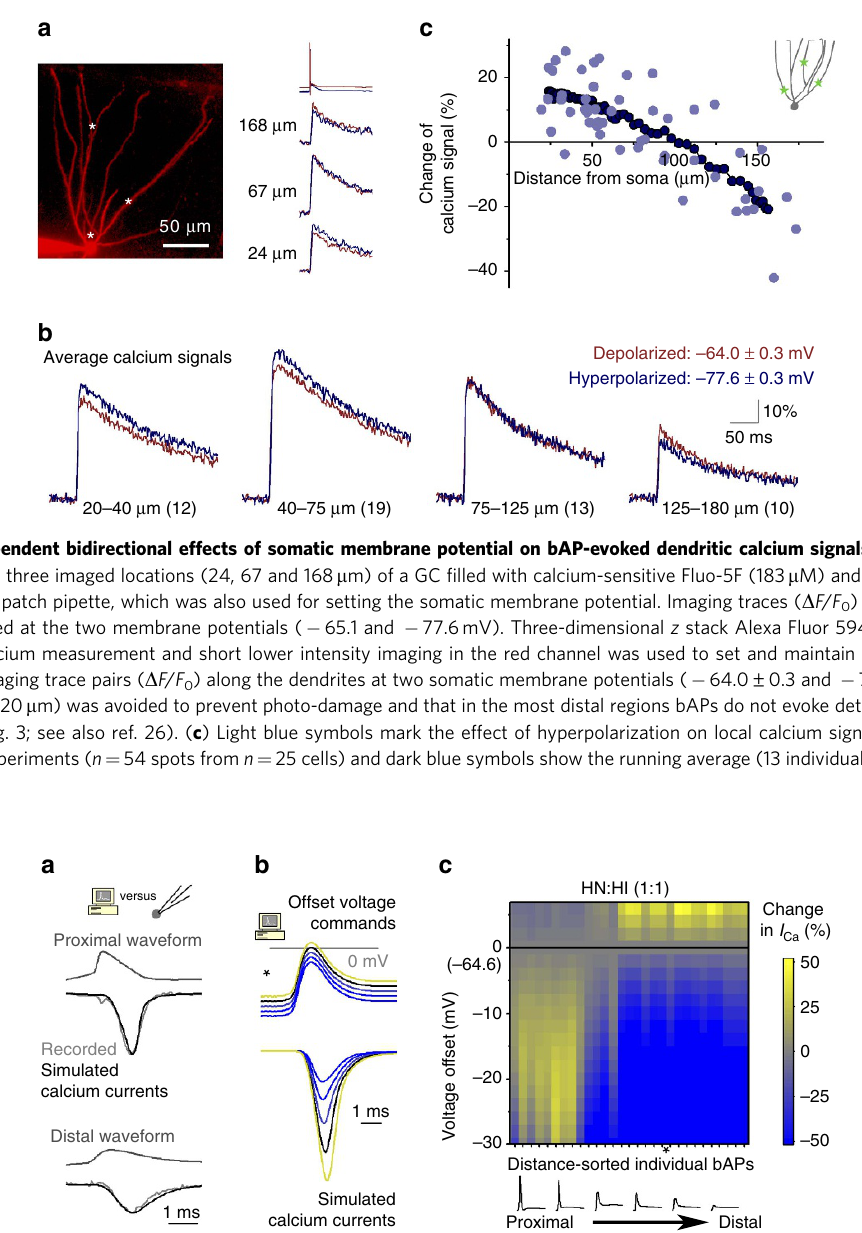
Figure 3 | The lower peak of the distal bAPs during hyperpolarization leads to smaller calcium influx. ( a ) Comparison of simulated composite calcium currents (HN:HI, for details see Supplementary Fig. 7 and Supplementary Table 1) with recorded HVA calcium currents (in the presence of NNC55-0396) evoked by proximal and distal bAP waveforms as voltage commands. ( b ) Simulated calcium influxes after shifting the entire voltage command traces in 2mVsteps in a representative experiment (originally recorded 116 m m from the soma). ( c ) The heat map summarizes the changes of the simulated calcium influx upon offsetting the command voltage in 2mV steps. Each column corresponds to one previously recorded bAP (six examples are shown below), which were sorted along the x axis according to the location of their recording. Zero voltage on the colour plot corresponds to the original recorded potential (depolarized, membrane potential: (cid:2) 64.6 ± 0.6mV). Notice the sensitivity of the small distal bAPs to small voltage shifts.